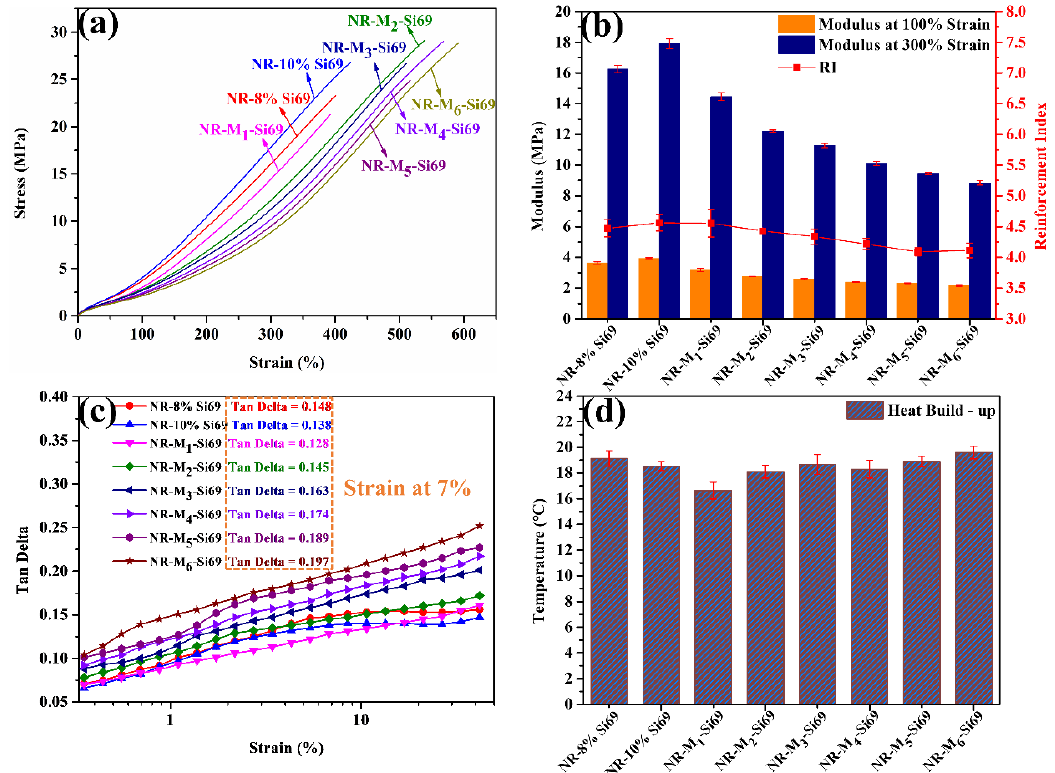
Figure 5. ( a ) Stress – strain curve, ( b ) modulus and reinforcement factor, ( c ) Tan delta at 60 °C, and ( d ) heat build-up of rubber nanocomposites.